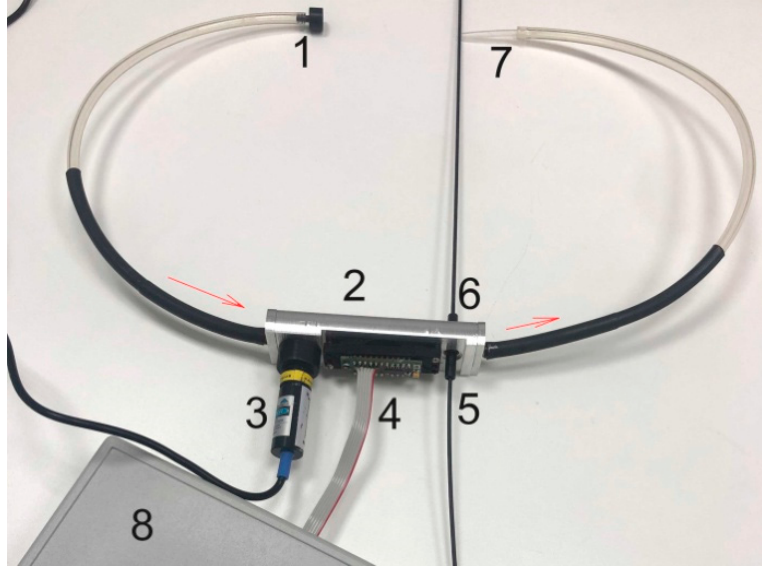
Figure 6. Photograph of the laser fluorescent milk flow sensor shown schematically in Figure 4: (1)